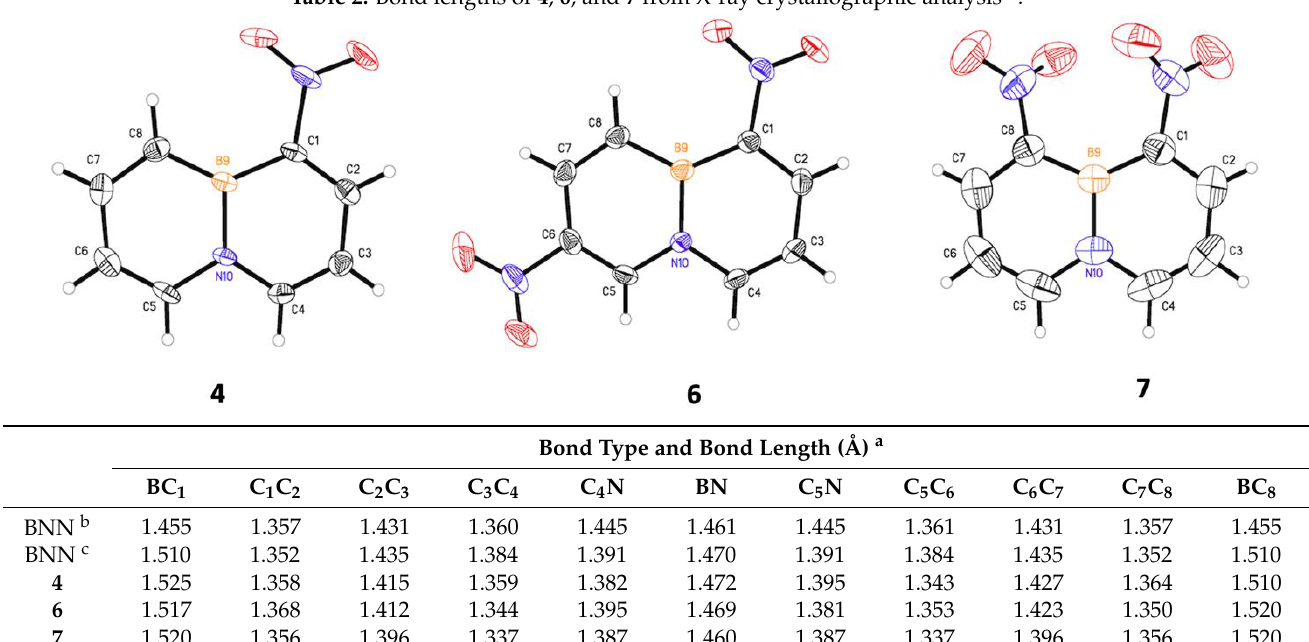
Table 2. Bond lengths of 4 , 6 , and 7 from X-ray crystallographic analysis a.